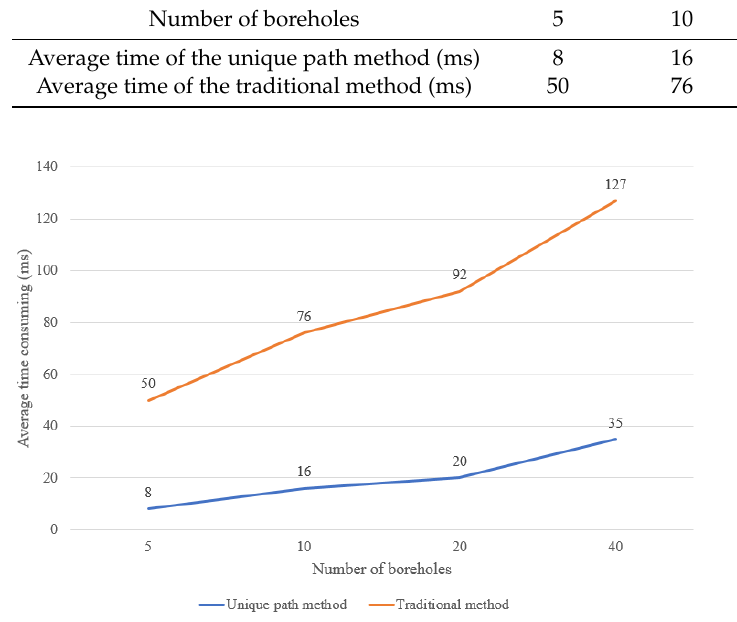
Figure 19. Comparison of computation time between the two methods with different numbers of boreholes. of